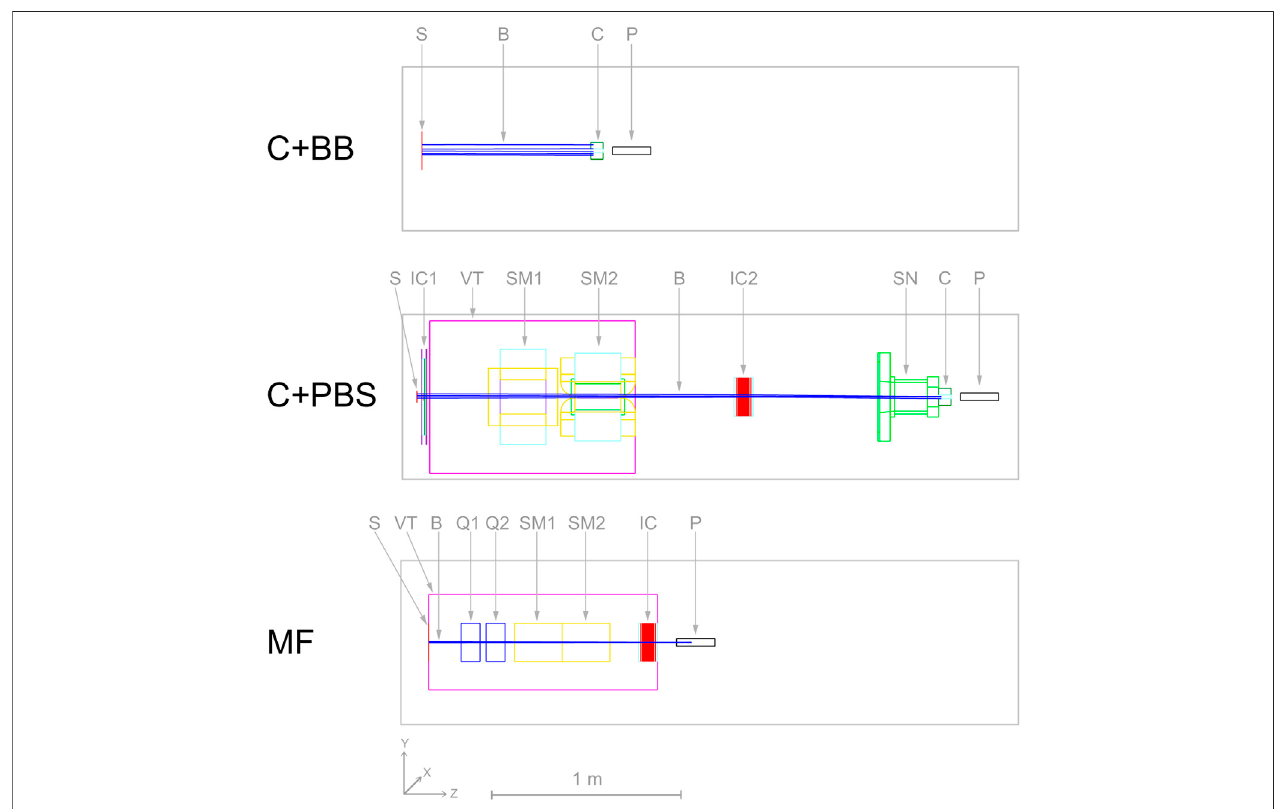
FIGURE2| Simulatedgeometriesofthethreedifferentminibeamgenerationtechniques.Abbreviationsstandfor:S-source,B-beam,C-collimator,P-phantom, IC - ionization chamber, VT - vacuum tank, SM - scanning dipole magnet, SN - snout, Q - focusing quadrupole magnet.